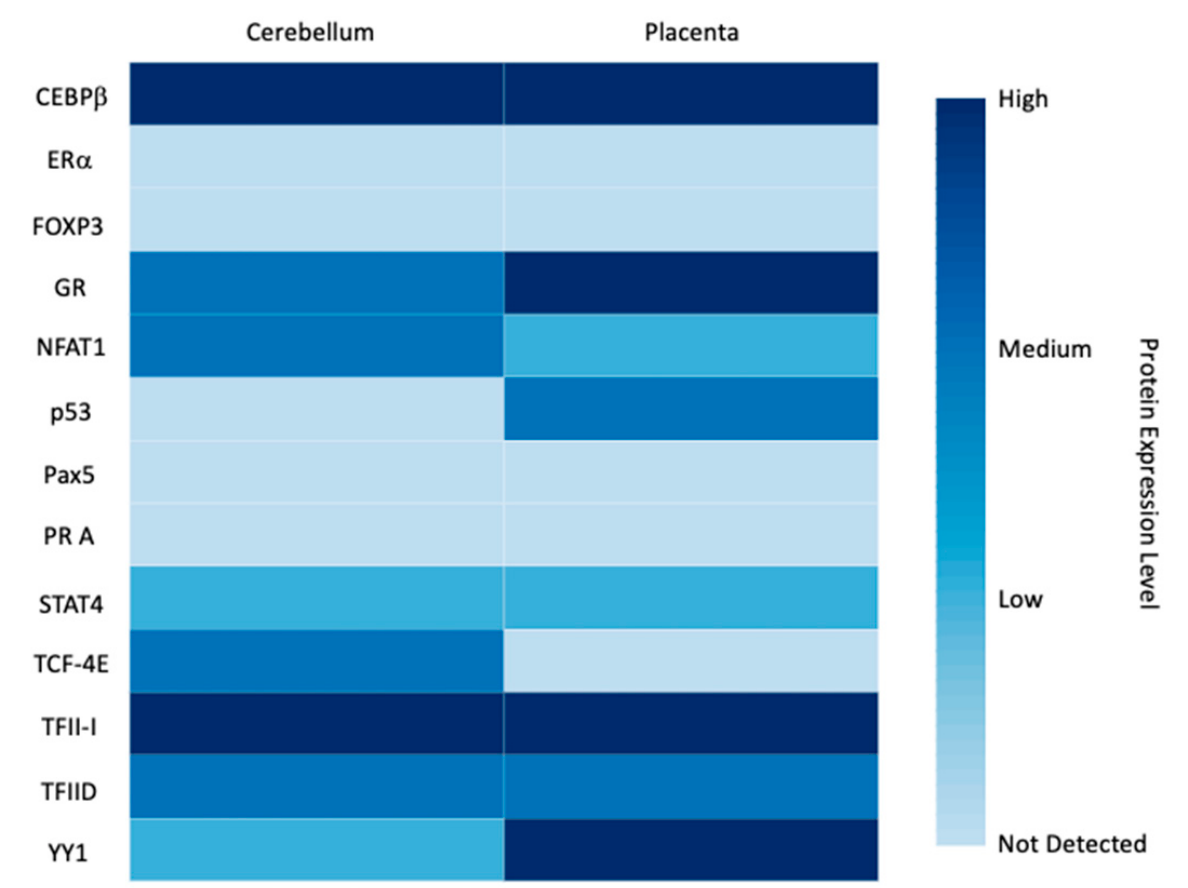
Figure 7. Protein expression patterns of predicted transcription factors for LGALS16 regulation in the cerebellum and placenta.